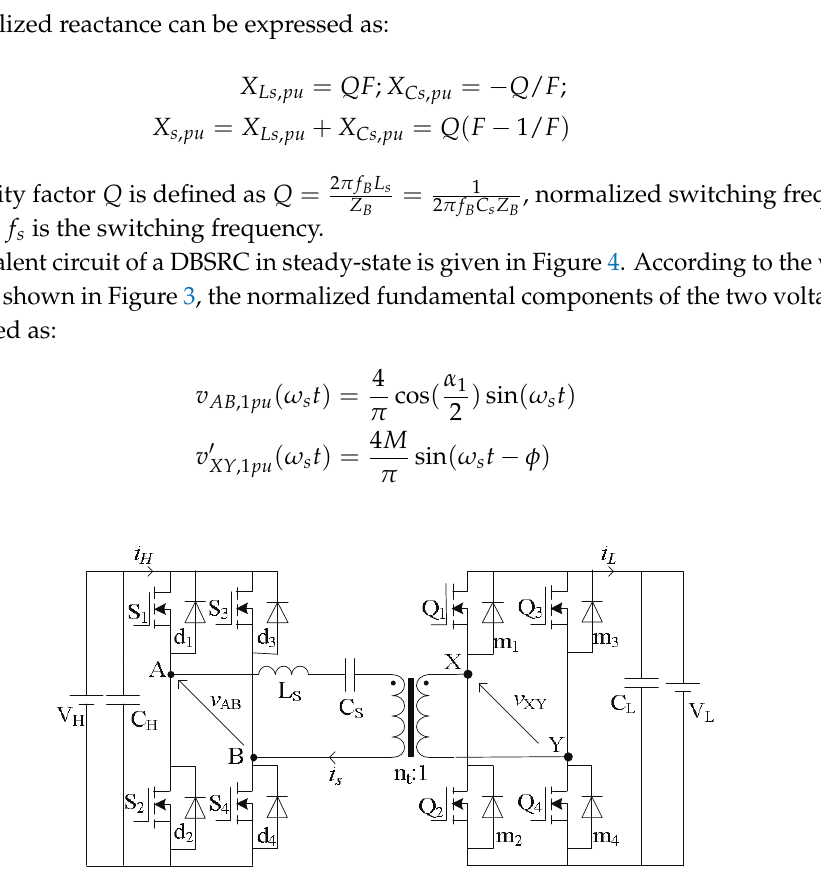
Figure 2. A dual-bridge series resonant